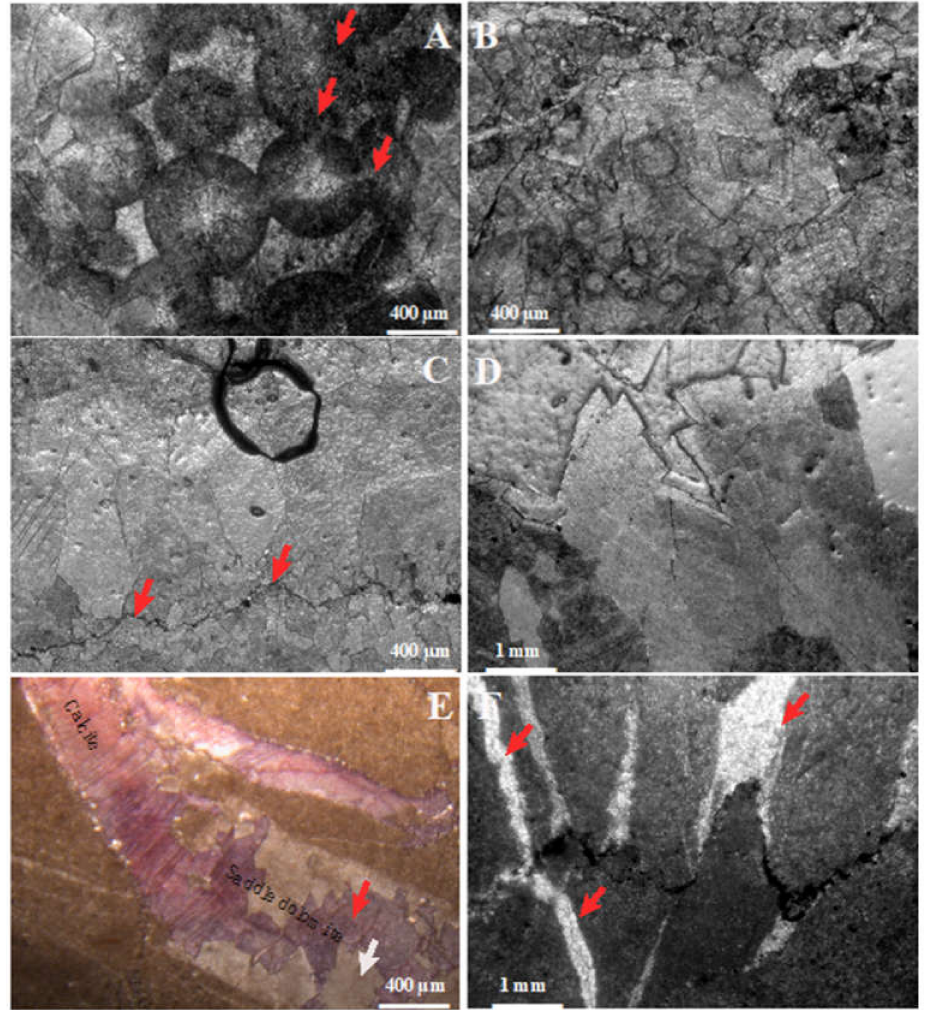
Figure 4. ( A ) The depositional texture is grain-supported with ooids (grainstones). The intergranular contacts between ooids are sutured and convexo–concave due to overburden load (arrows). ( B ) Transition from a mostly anhedral dolomite D2 T to a euhedral saddle dolomite SD2 T separated by an irregular stylolite indicating that these dolomites were formed at di ff erent time. ( C ) Early stylolite (arrows) cross-cuts SD1 T with precipitation of sulfide minerals. ( D ) Light brown saddle dolomite SD3 T , showing coarse crystal size and pressure dissolution. ( E ) Macroscopic fracture showing Fe-rich SD3 T (red arrow) and Fe-poor SD2 T (white arrow). A late-stage Fe-poor calcite cement appears at the top left (staining). ( F ) Arrows point to sets of tension gashes filled by Fe-rich SD3 T fracture. The fractures and columns of stylolite (red arrows) are in the same direction and this could be related to the mechanical overburden in the deep burial diagenetic